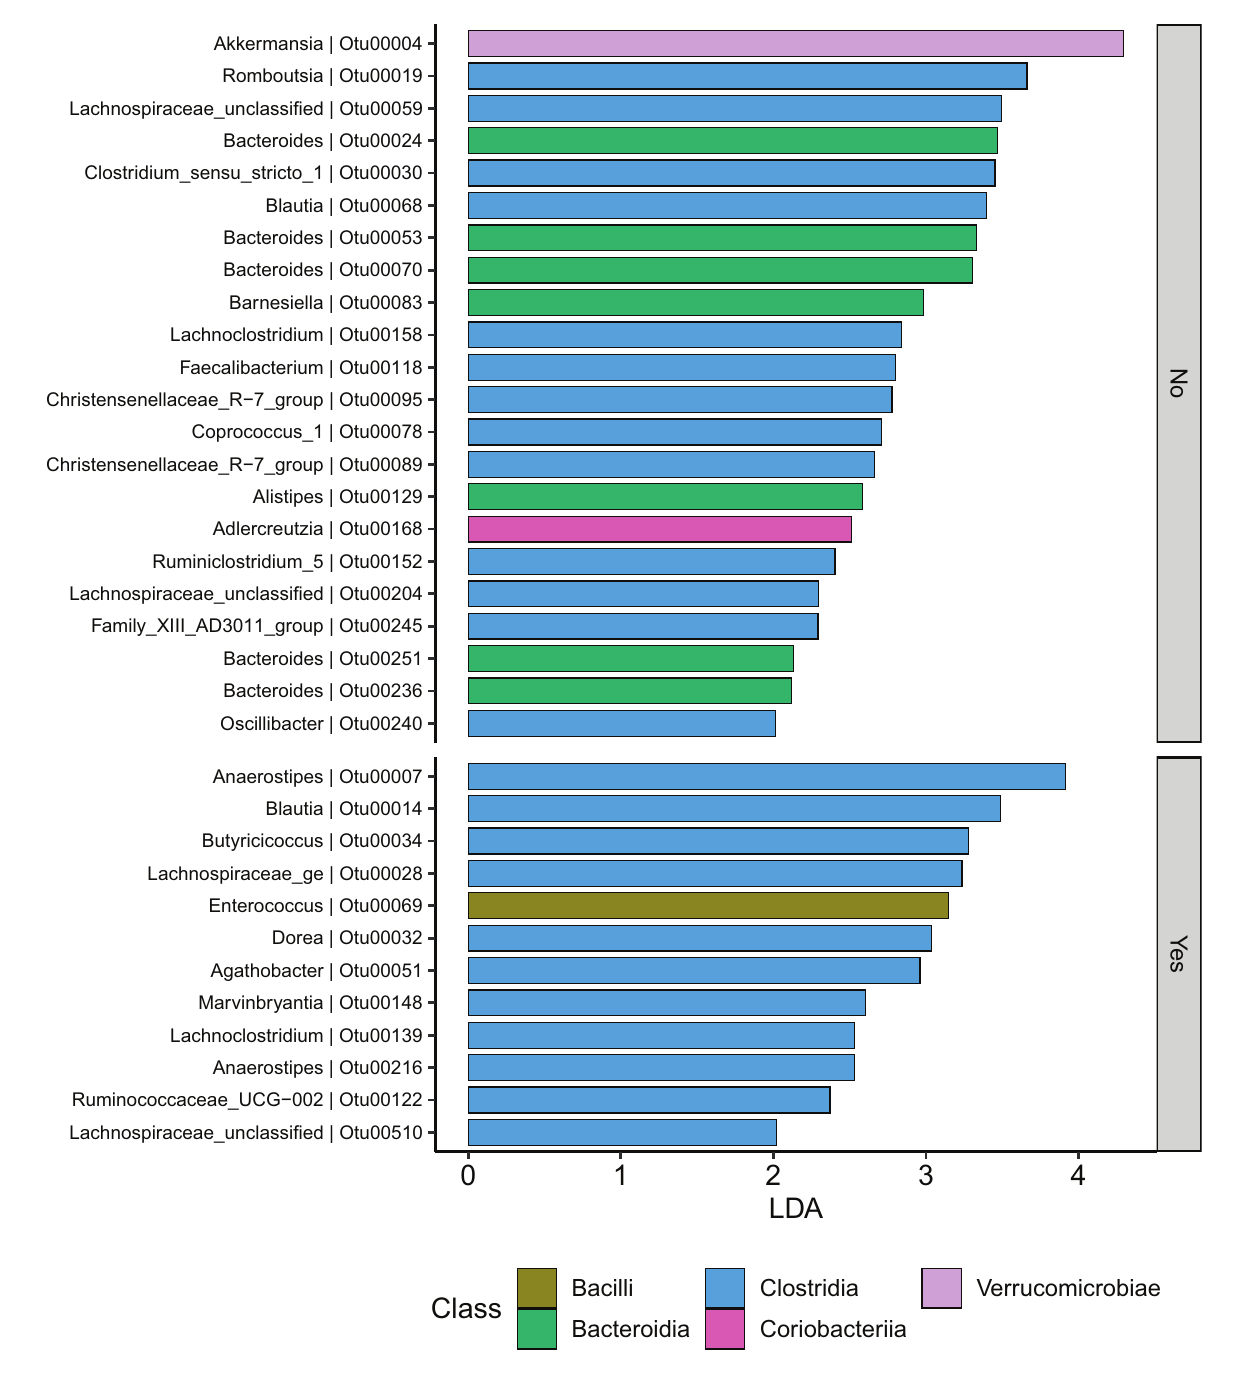
have shown a clear reduction in Firmicutes and significant decrease of many other beneficial bacterial species from the genera Lactobacillus , Eubacterium and Bacteriodes